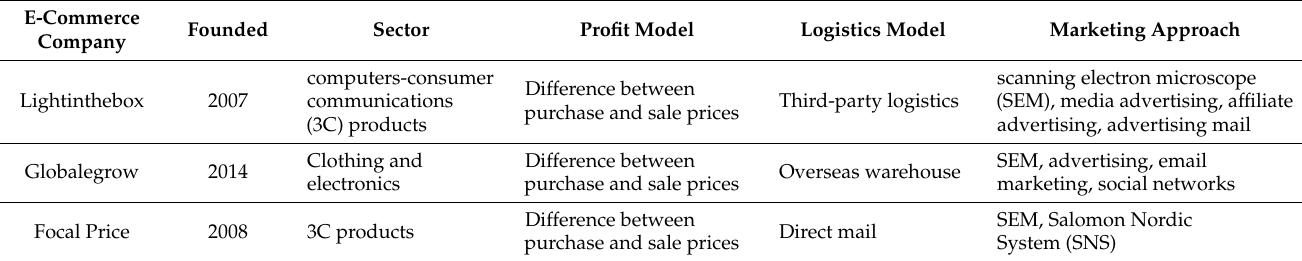
Table 2. Overview of Chinese companies with cross-border business to consumer (B2C) operating model.